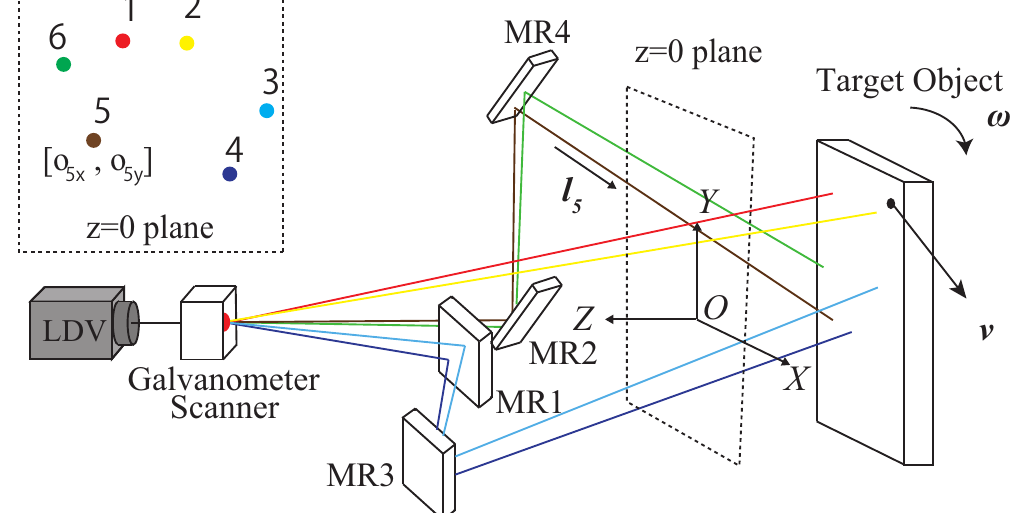
Figure 1. System to be calibrated and its parameters. Laser beams emitted from the laser Doppler velocimeter (LDV) are reflected by the galvanometer scanner and mirror array MR1~MR4, and finally hit a moving-target object. By scanning the laser on the target surface, the six-degree-of-freedom (6-DOF) speed of the target could be reconstructed. Parameters consist of laser geometry, denoted by the x and y co-ordinates on the z = 0 plane, and the laser-direction angles.